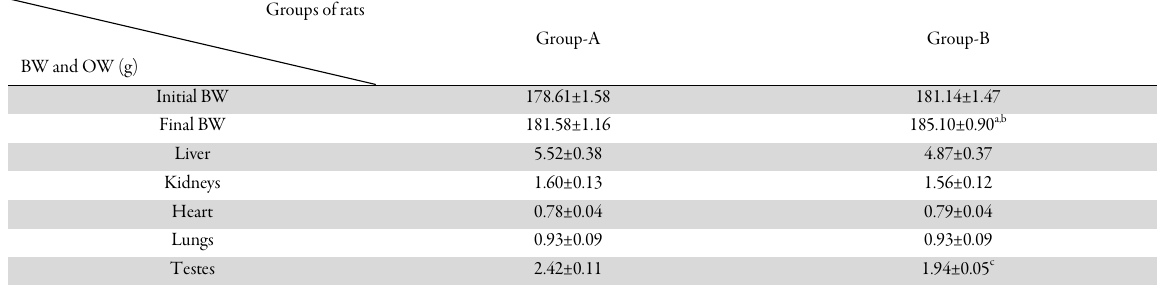
Table 5. Organ weight and body weight of rats treated with vehicle and SNPs 2000mg/kg. n=5±SE of mean, a=p<0.05, b=p<0.025, c=p<0.005 Groups of rats